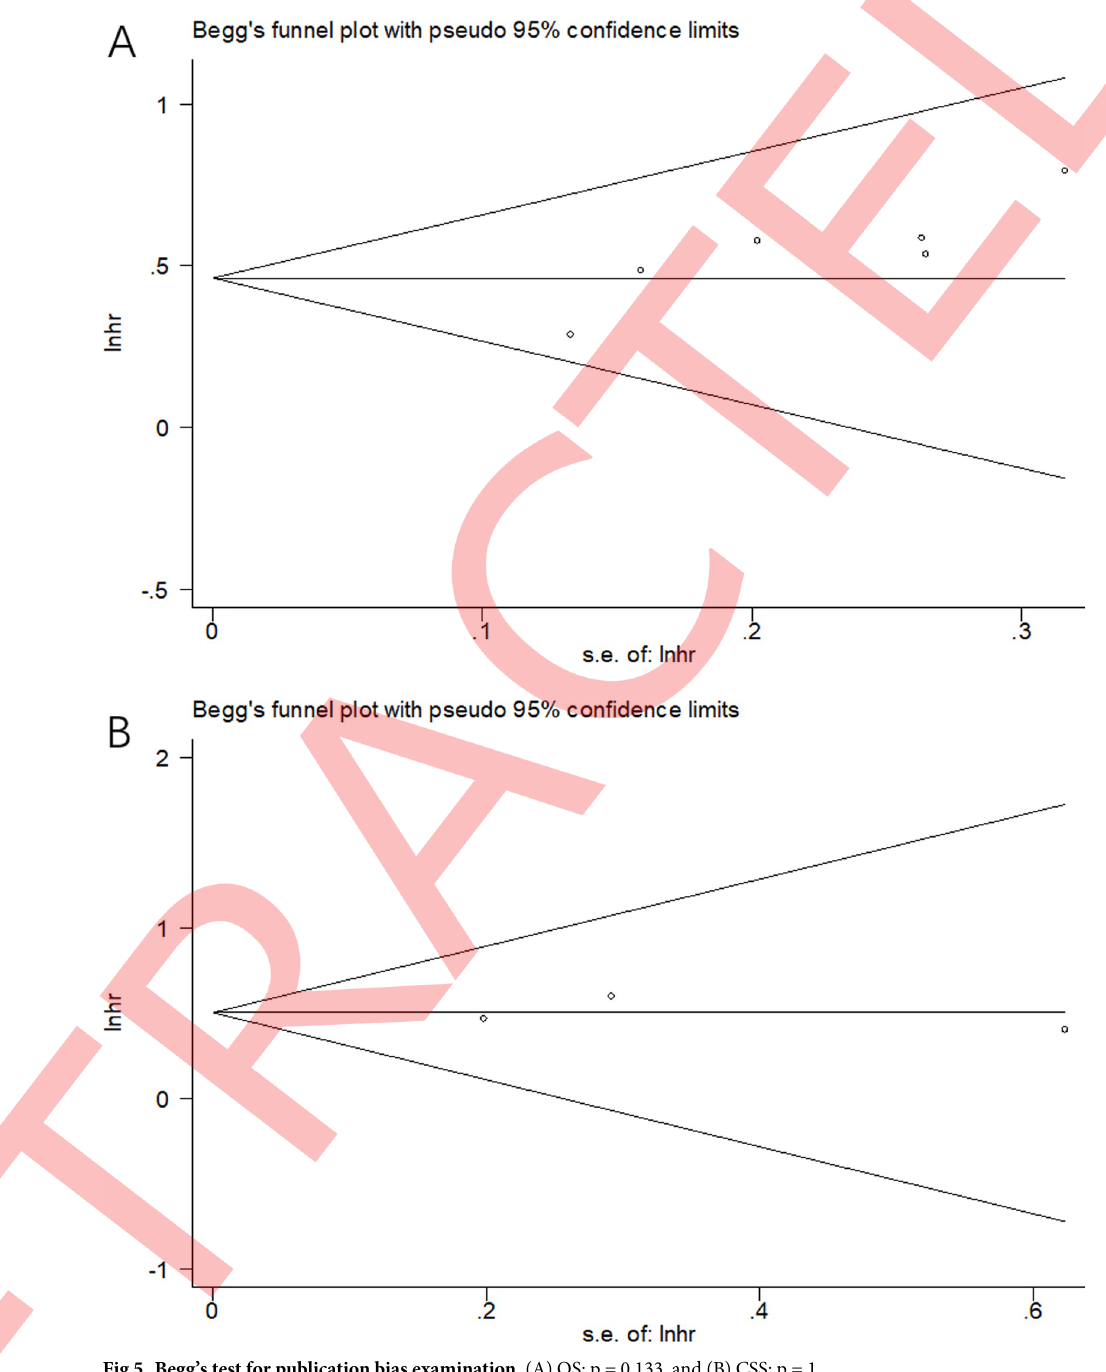
Fig 5. Begg’s test for publication bias examination. (A) OS: p = 0.133, and (B) CSS: p = 1. These diverse thresholds could lead to inconsistent recruitment of patients and cause heteroge- neity among studies. Fourth, the sample size for the correlation of CAR and clinicopathologi- cal factors were relatively small. Only 3 studies with 850 cases were included, which may lead to selection bias in this meta-analysis.